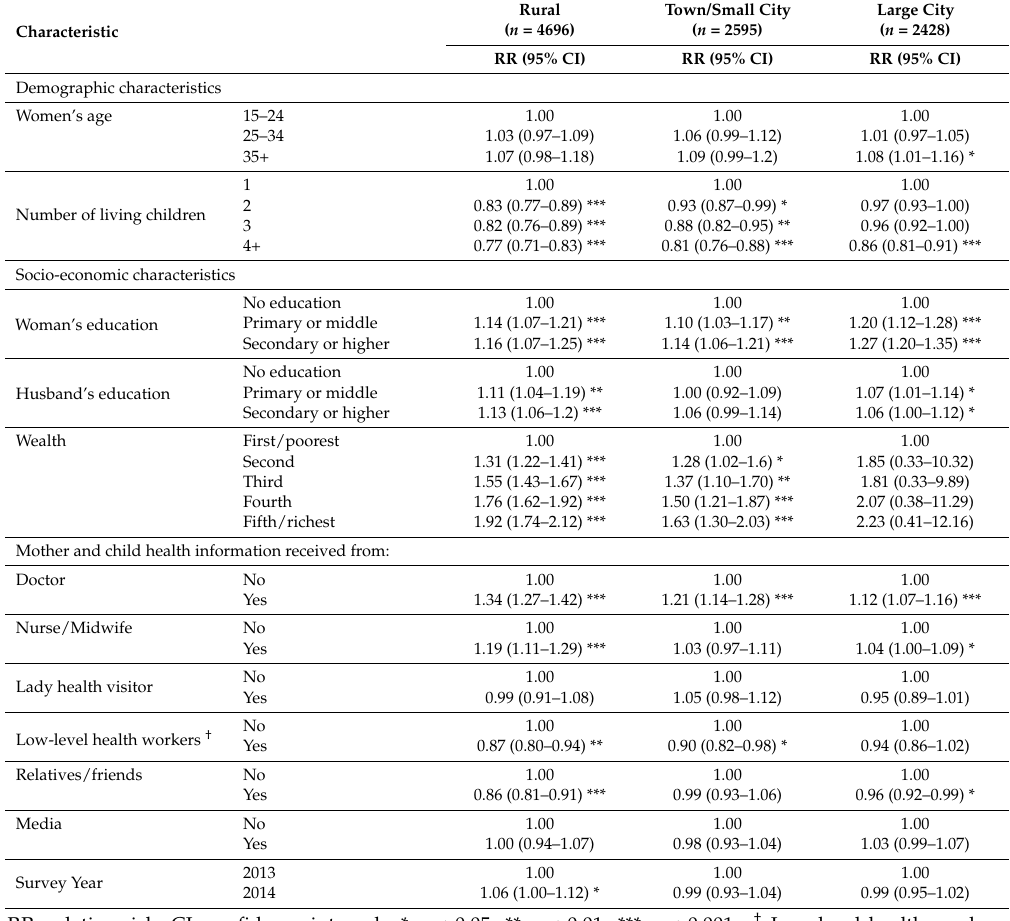
Table 3. Generalized linear model with log link and a Poisson distribution: results of residence subgroup analysis to choose a medical facility as the place of